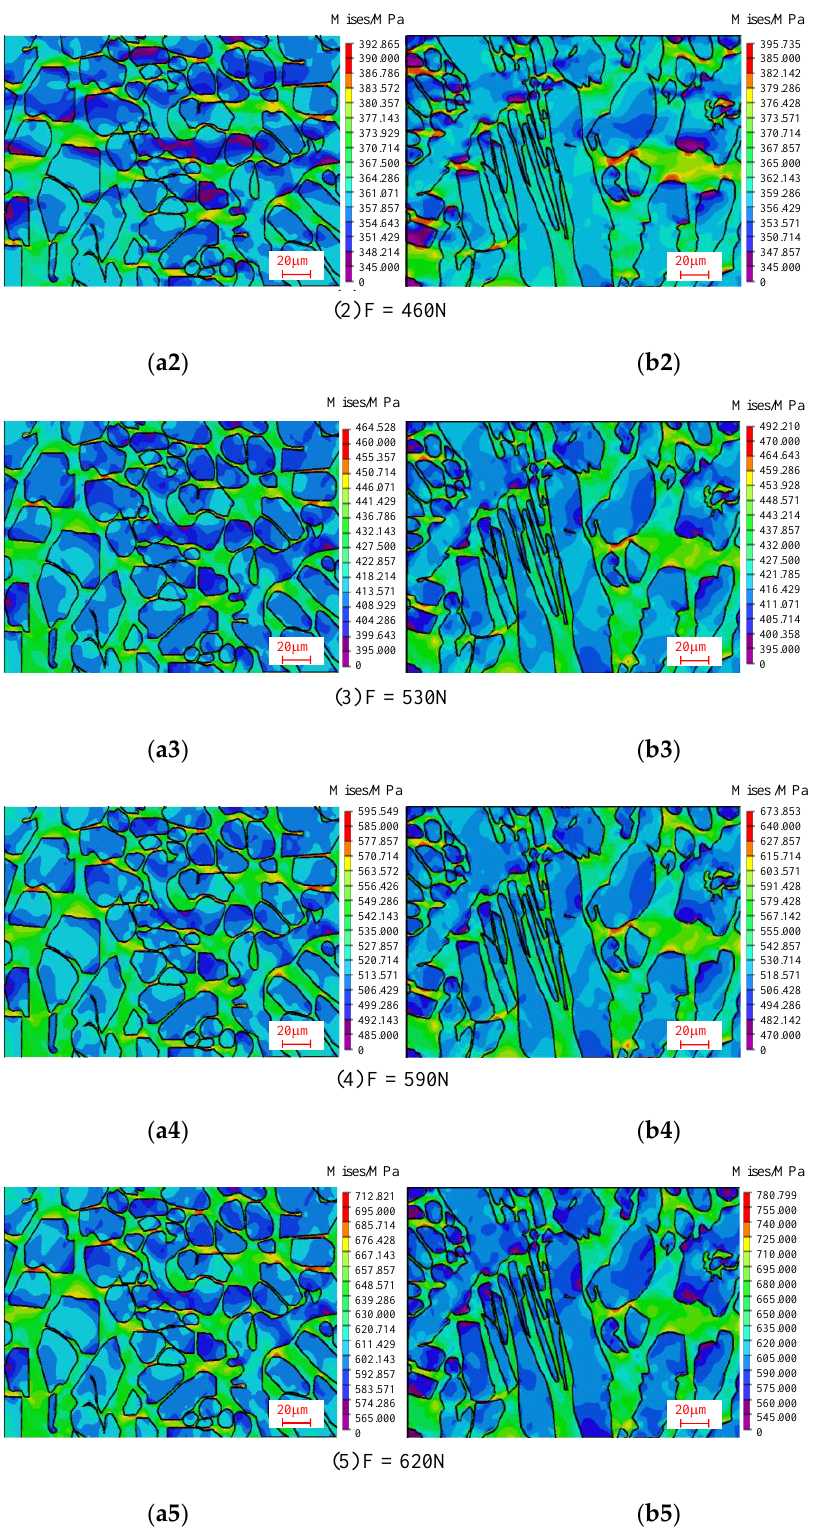
Figure 13. Stress distribution contours under different loads: ( a1 – a5 ) 1# region, ( b1 – b5 ) 2# region. According to the stress distribution map, the larger stress is concentrated on the ferrite phase in both region 1# and region 2# under a certain load, indicating that the strength of the ferrite is relatively higher. Pronounced growth of stress appears as the loading level increases. It can be concluded from Figure 13 that the internal stress in ferrite phases is